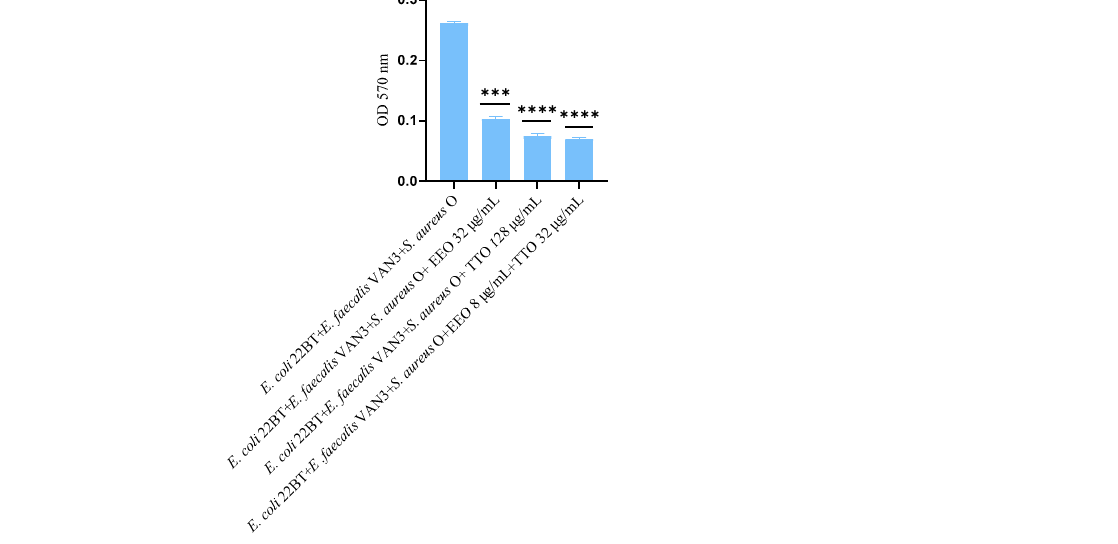
Figure 3. Anti-multi-species-biofilm formation activity of Melaleuca alternifolia (TTO), Eucalyptus globulus (EEO) EOs and of the association EEO/TTO. Results were expressed in optical density (OD) 570 nm as the arithmetic mean of the three determinations. p -values of <0.05 (*), p < 0.01 (**), p < 0.001 (***) and p < 0.0001 (****) were considered significant by t-test and ANOVA.